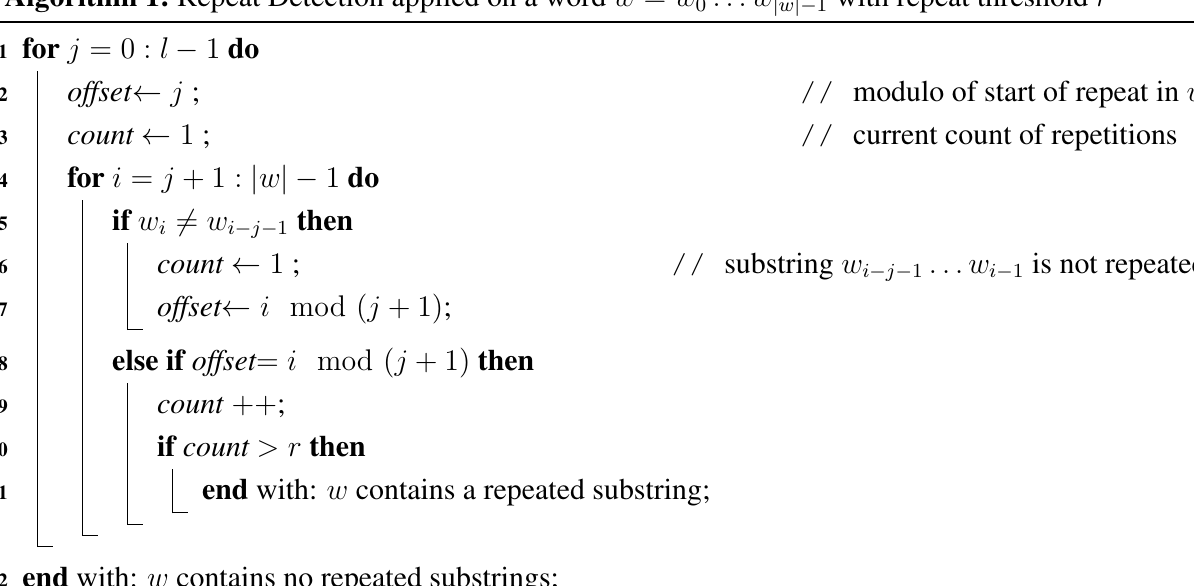
Algorithm 1: Repeat Detection applied on a word w = w